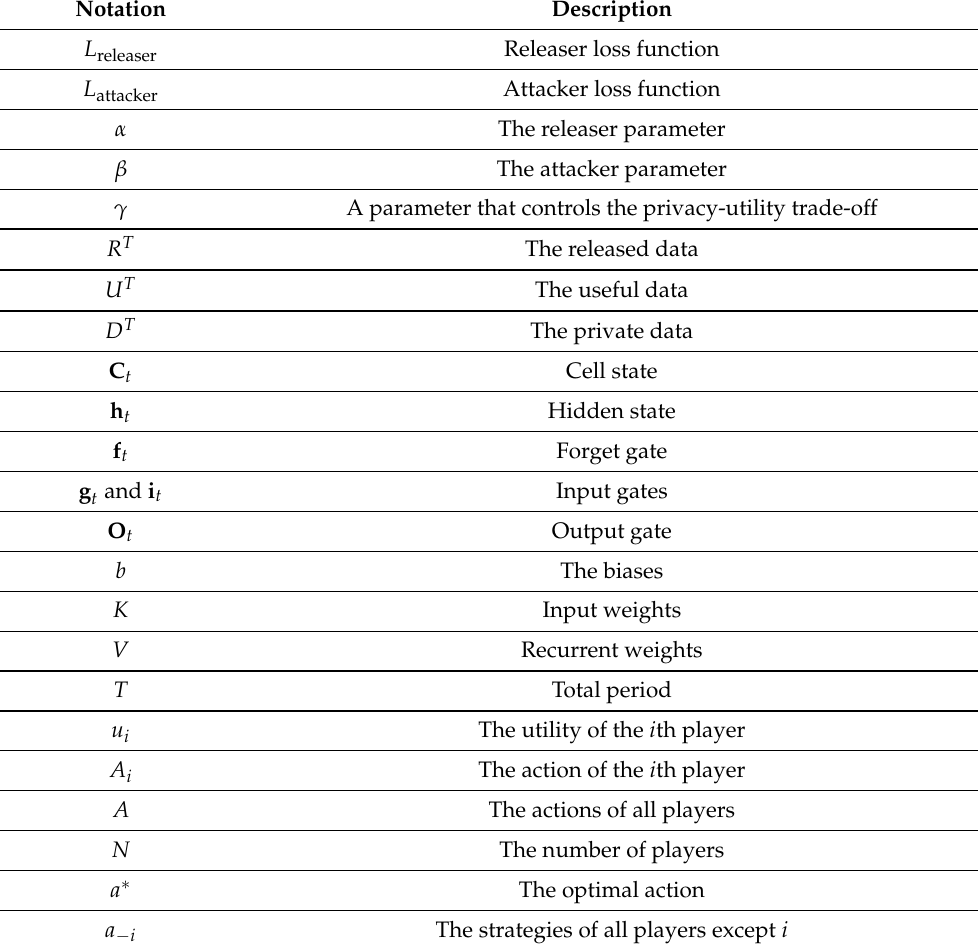
Table 2. The Frequently Used